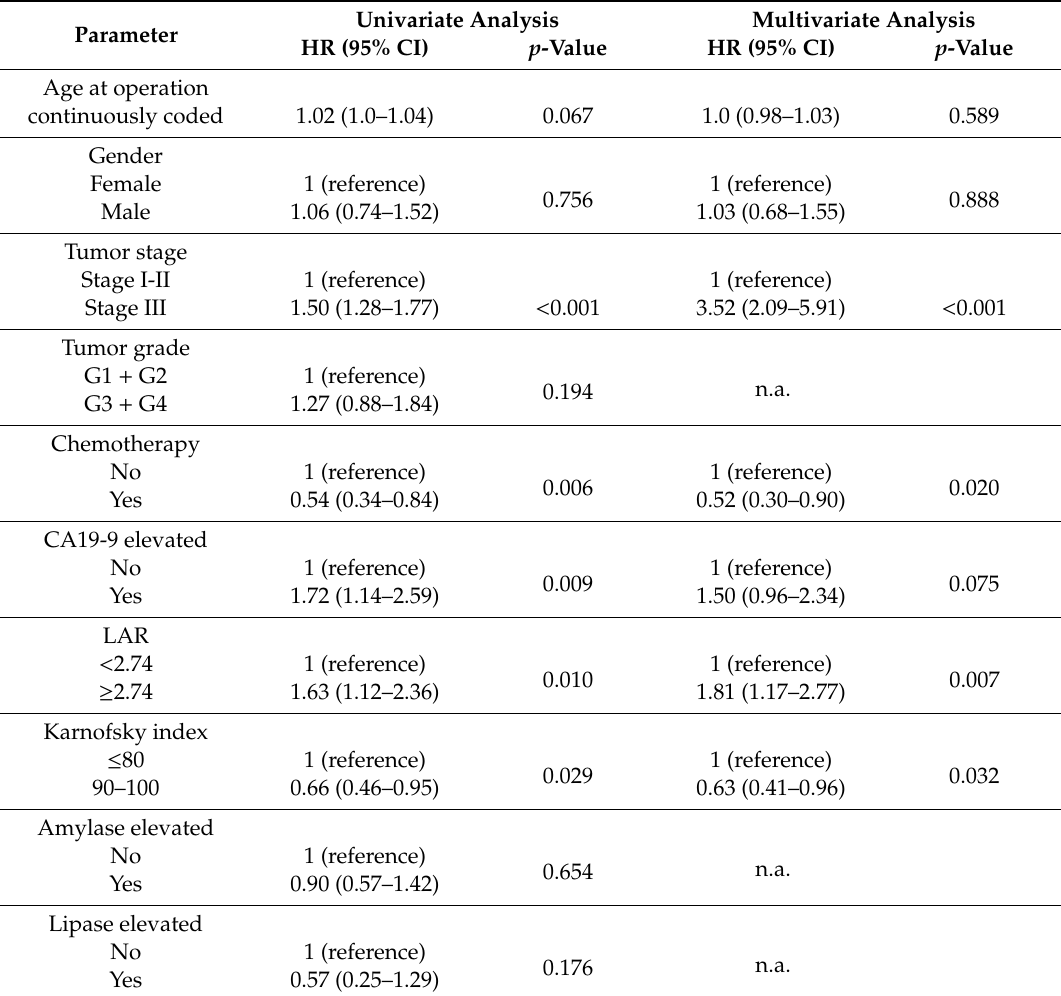
Table 2. Univariate and multivariate Cox regression analyses regarding cancer-specific survival in